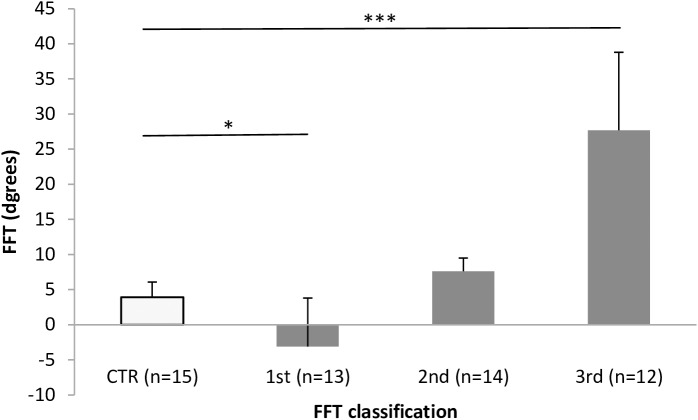
Comparison of FFT angle in control group and FFT tertiles.Significant differences with FFT angle of the control group are apparent in the 1st tertile (p = 0.02) and 3rd tertile (p<0.001). No significant difference is seen in the 2nd tertile (p = 0.36). *p < 0.05; ***p < 0.001. FFT: forward flexion of trunk.